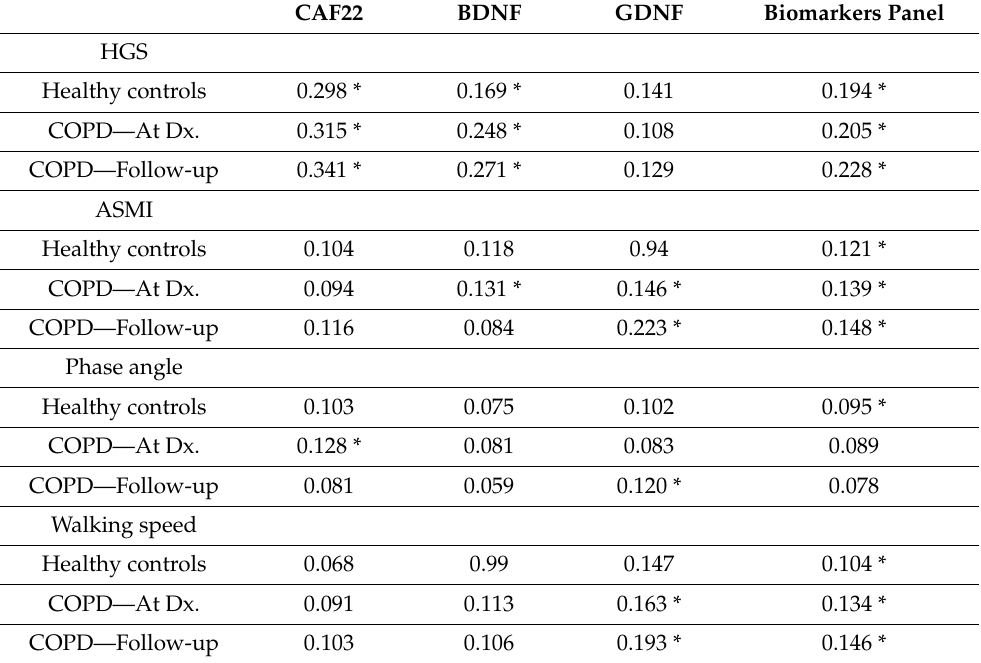
Table 4. Correlation coefficients of circulating biomarkers with the indexes of sarcopenia and the phase angle in healthy controls and patients with COPD at diagnosis (Dx) and follow-up ( n = 77–84/group); * p <